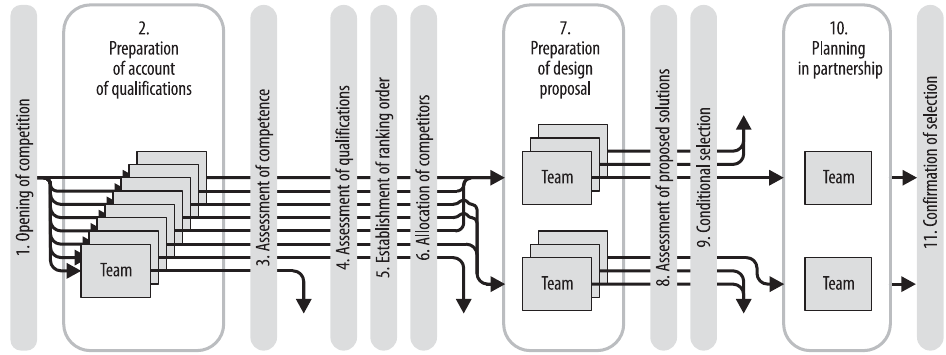
Figure 2. The tasks of the process for selecting planning